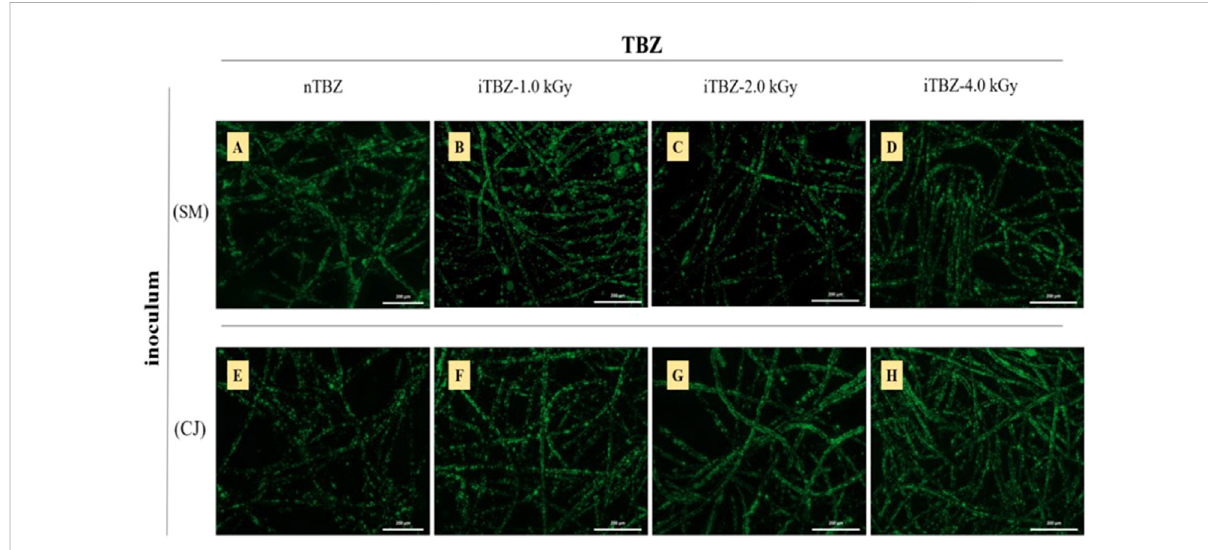
FIGURE 3 Assessmentofmicrobialproliferationontheoutersurfaceofcarbonfeltelectrodesbyepi fl uorescencemicroscopyimaging.Thesurfaceofthe carbon felt electrode was stained with acridine orange to localize microbial cells. Bioanodes were formed at different inoculums and with nTBZ or iTBZ (A) SM and nTBZ (B) SM and iTBZ-1.0 kGy (C) SM and iTBZ-2.0kGy (D) SM and iTBZ-4.0kGy (E) CJ and nTBZ (F) CJ and iTBZ-1.0kGy (G) CJ and iTBZ-2.0kGy (H) CJ and iTBZ-4.0